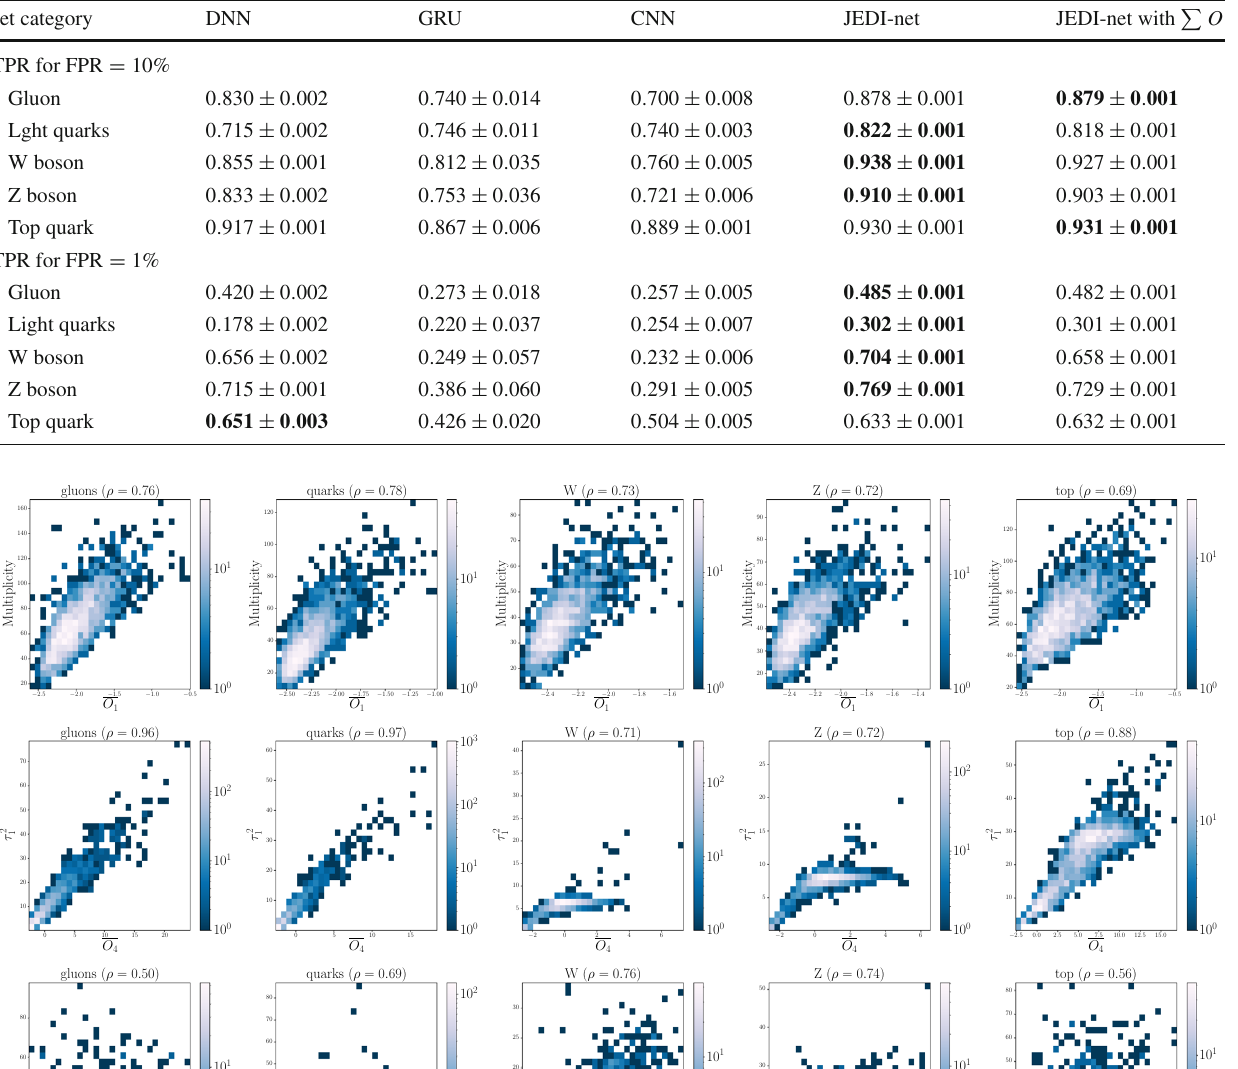
Table 3 True positive rates (TPR) for the optimized JEDI-net taggers and the three alternative models (DNN, CNN, and GRU), corresponding to a false positive rate (FPR) of 10% (top) and 1% (bottom). The largest TPR value for each case is highlighted in bold Jet category DNN GRU CNN JEDI-net JEDI-net with TPR for FPR = 10%